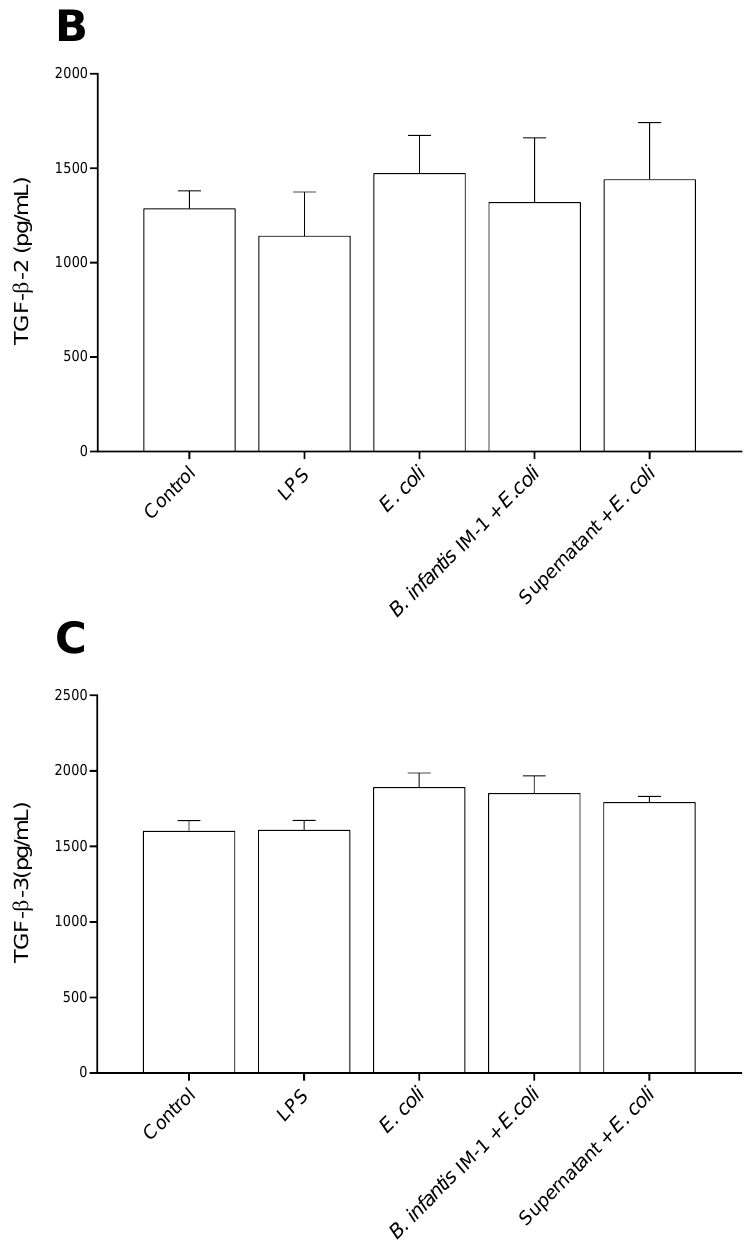
Figure 6. TGF- β levels in the culture medium of co-cultures of Caco-2 and DCs after 1 h of treatments. ( A ) TGF- β 1. ( B ) TGF- β 2. ( C ) TGF- β 3. Results are expressed in pg/mL as the mean ± SEM of three independent experiments.